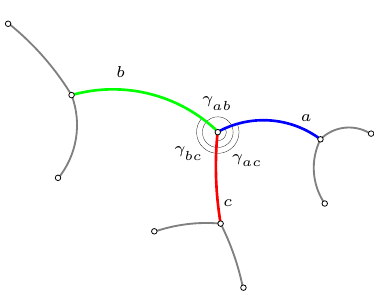
Figure 3 . Steiner tree on the non-Euclidean plane with four Fermat-Torricelli points. The middle